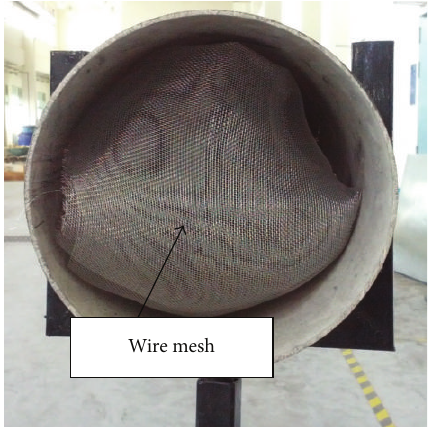
Figure 4: Location of wire mesh inside the